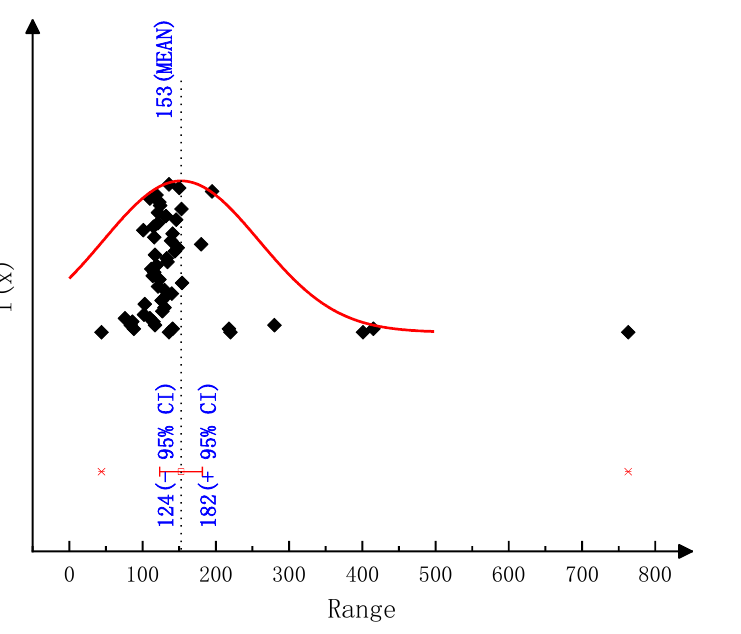
Figure A7. 95% confidence interval for the activation energy E F,1 of CYA pyrolysis reaction.